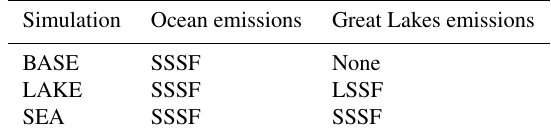
Table 1. Summary of the three emission scenarios: BASE, LAKE, and SEA. Simulation Ocean emissions Great Lakes emissions BASE SSSF None LAKE SSSF LSSF SEA SSSF